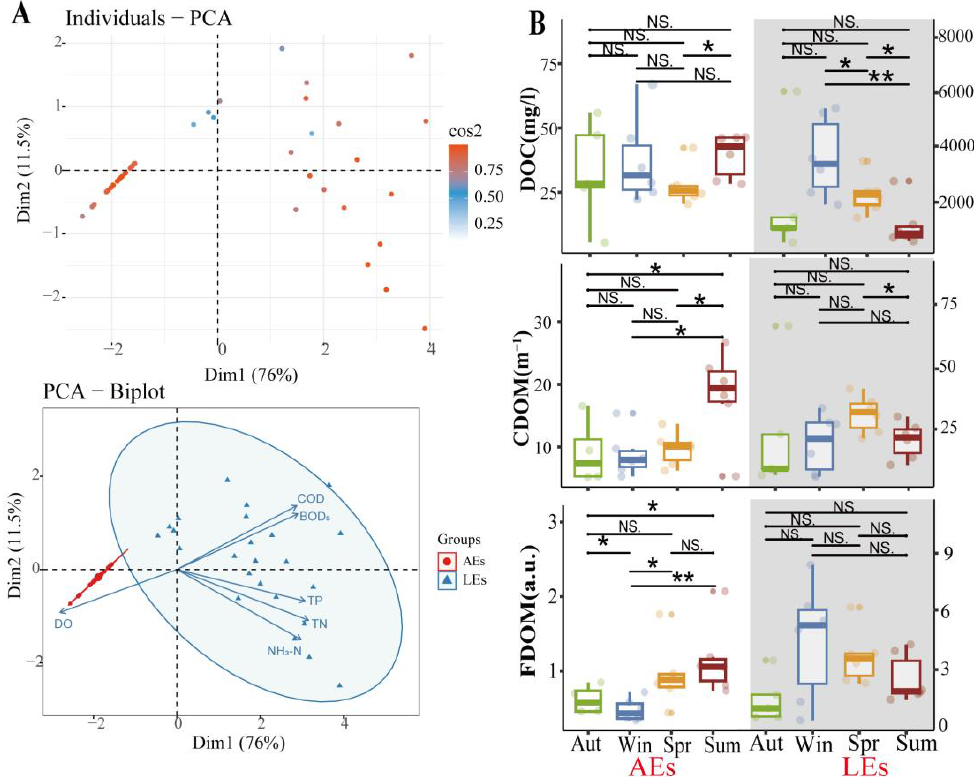
Figure 3. ( A ) Principal component analysis (PCA) of water quality parameters (TN, TP, COD, DO, BOD 5 , and NH 3 -N) of AEs and LEs; ( B ) Seasonal variation in DOM parameters in AEs and LEs, seasonal difference U-test for AEs and LEs; * represents p < 0.05, ** represents p < 0.01. NS. stands for no seasonal variation.